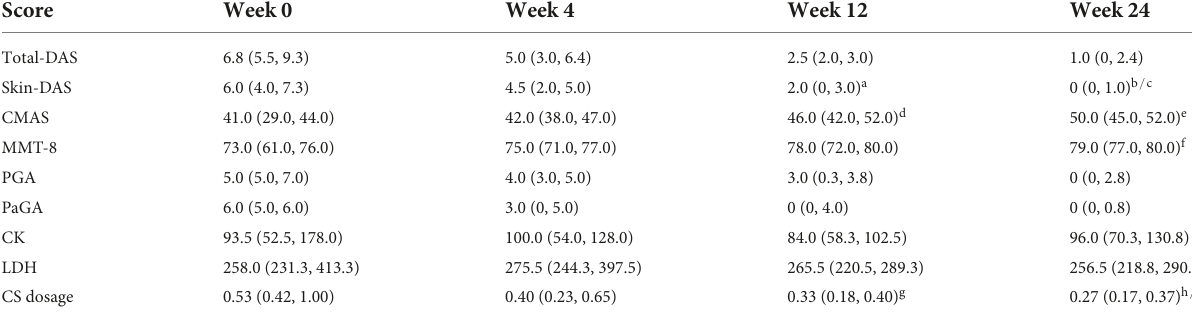
TABLE 1 Effectivenessand daily dose of corticosteroids (CS) in patients with baricitinib